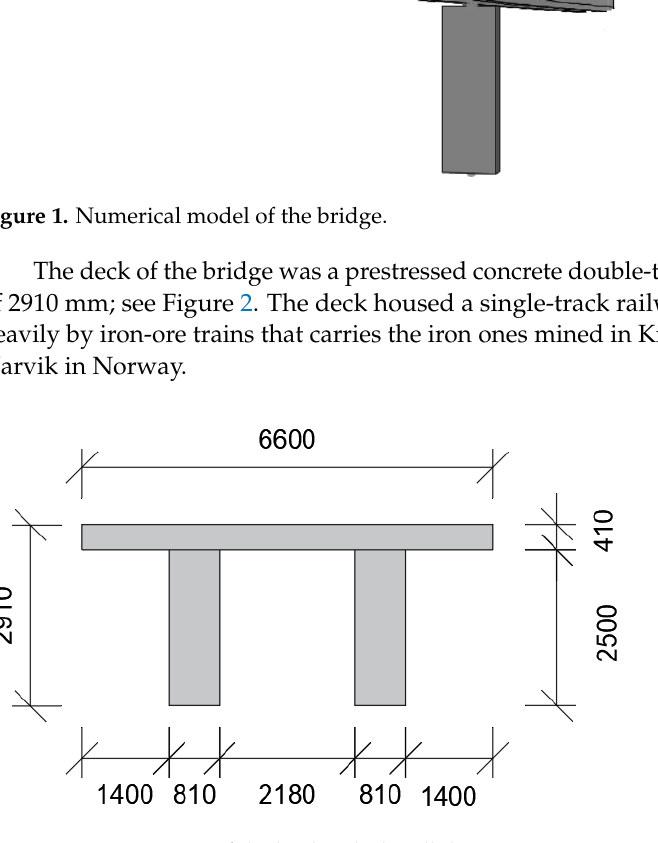
Figure 2. Cross-section of the bridge deck. All dimensions are in